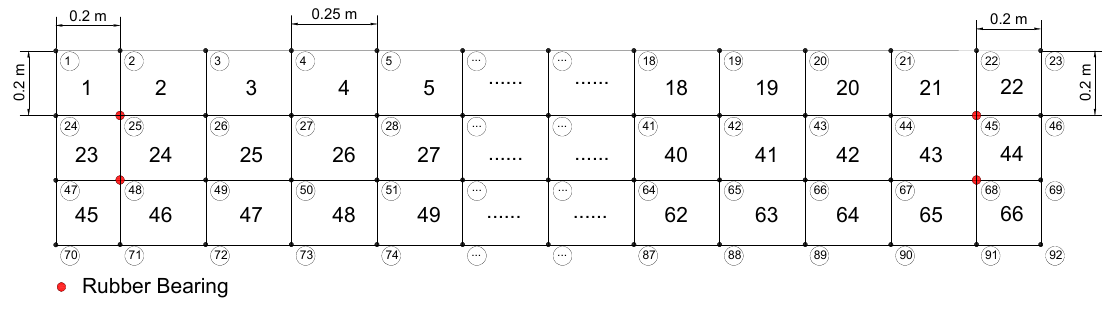
Figure 13. The numbering diagram of elements and nodes. Table 8. The analytical and experimental natural frequencies.